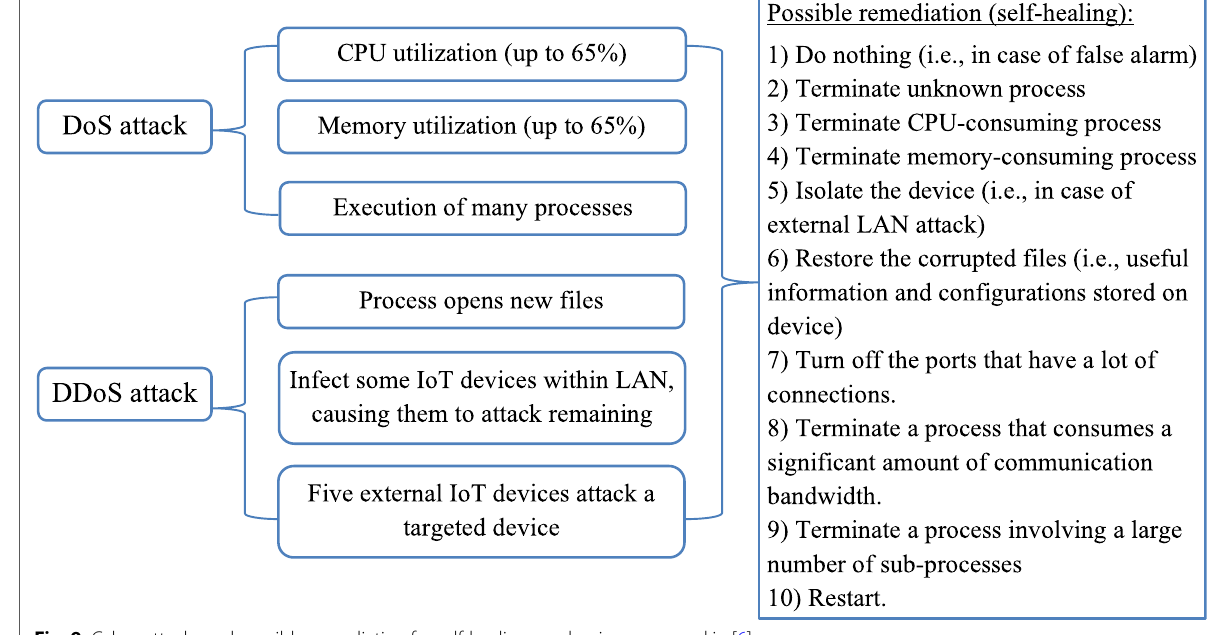
Fig. 9 Cyber-attacks and possible remediation for self-healing mechanism proposed in